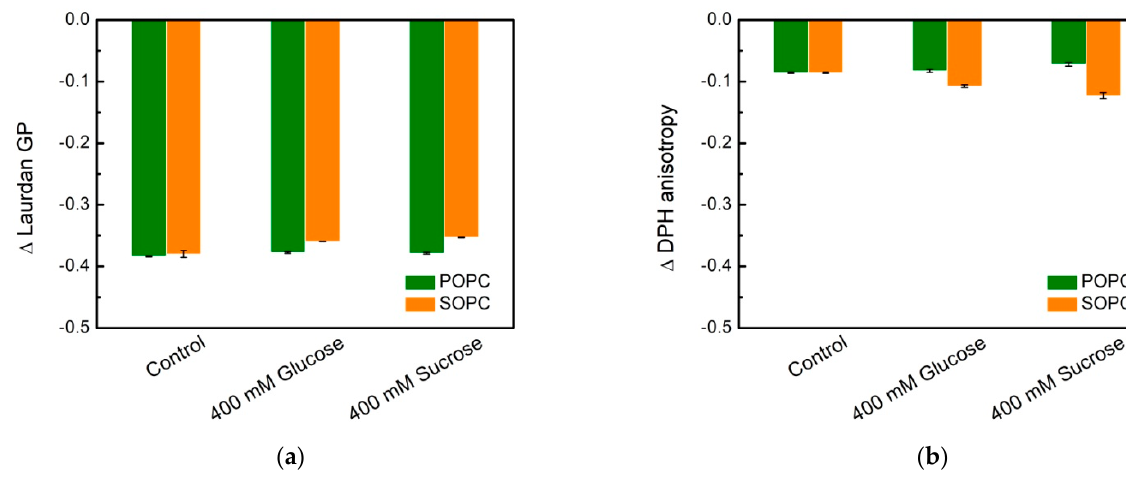
Figure 8. Lipid packing and membrane fluidity in single-component POPC and SOPC vesicles in water (controls) and in 400 mmol/L sugar solutions (glucose and sucrose): ( a ) ∆ Laurdan GP is defined as the difference between GP at 60 and 20 °C; ( b ) ∆ DPH anisotropy is defined as the difference between anisotropy at 60 and 20 °C. DPH anisotropy and Laurdan GP values represent the mean of three independent experiments. Error bars represent standard errors.